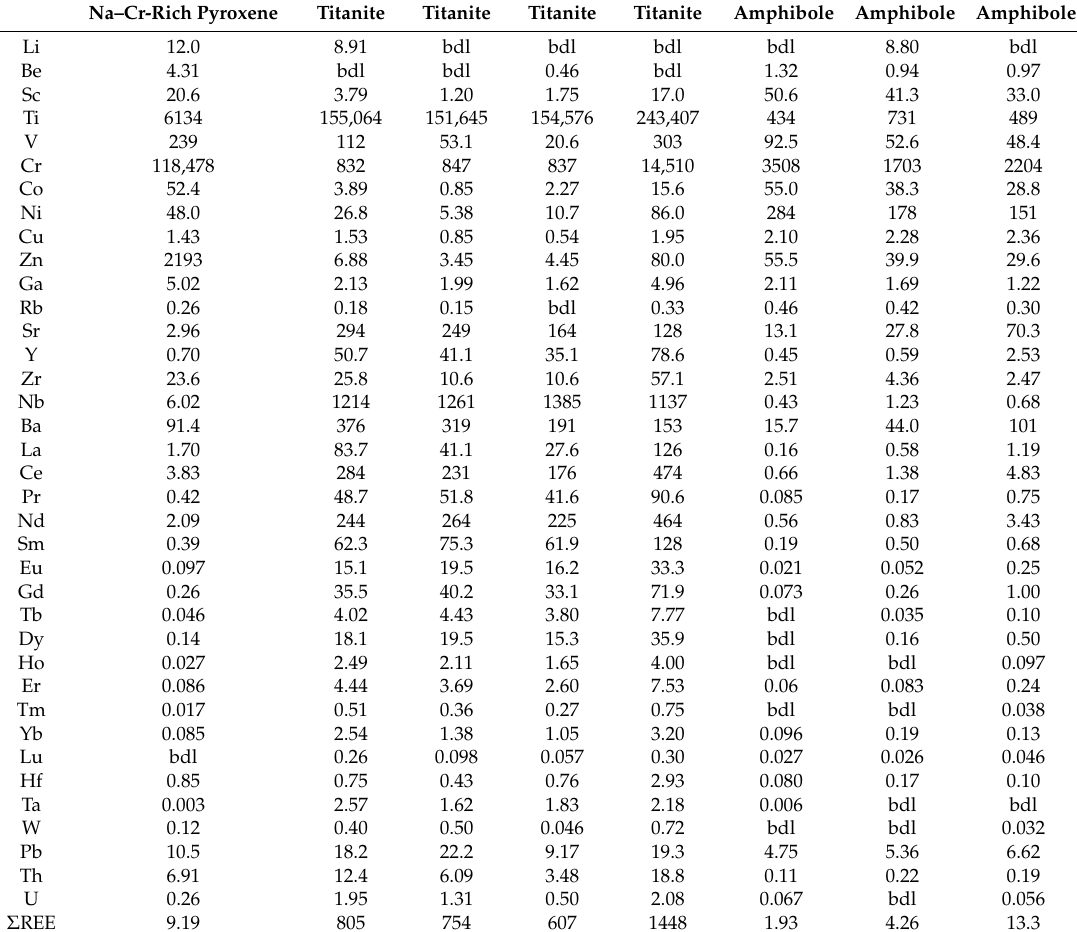
Table 2. Trace element concentrations in sample IC03B analyzed by